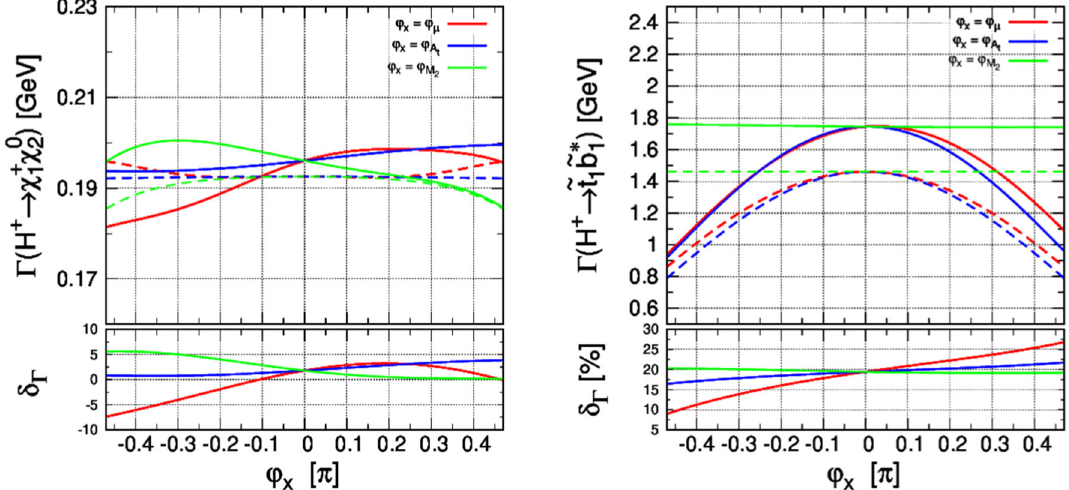
˜ b ∗ ) as a function of ϕ μ (red), ϕ 1 1